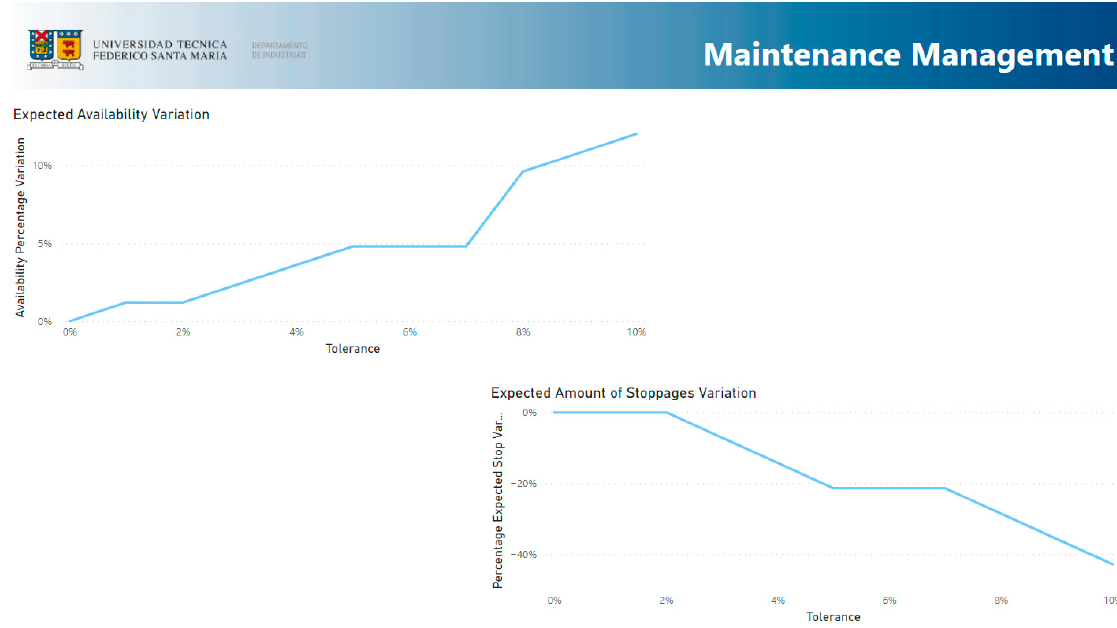
Figure 5. Physical asset management section.